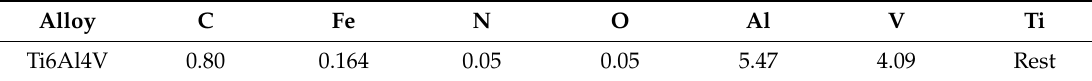
Table 1. Machined alloy composition (mass %).